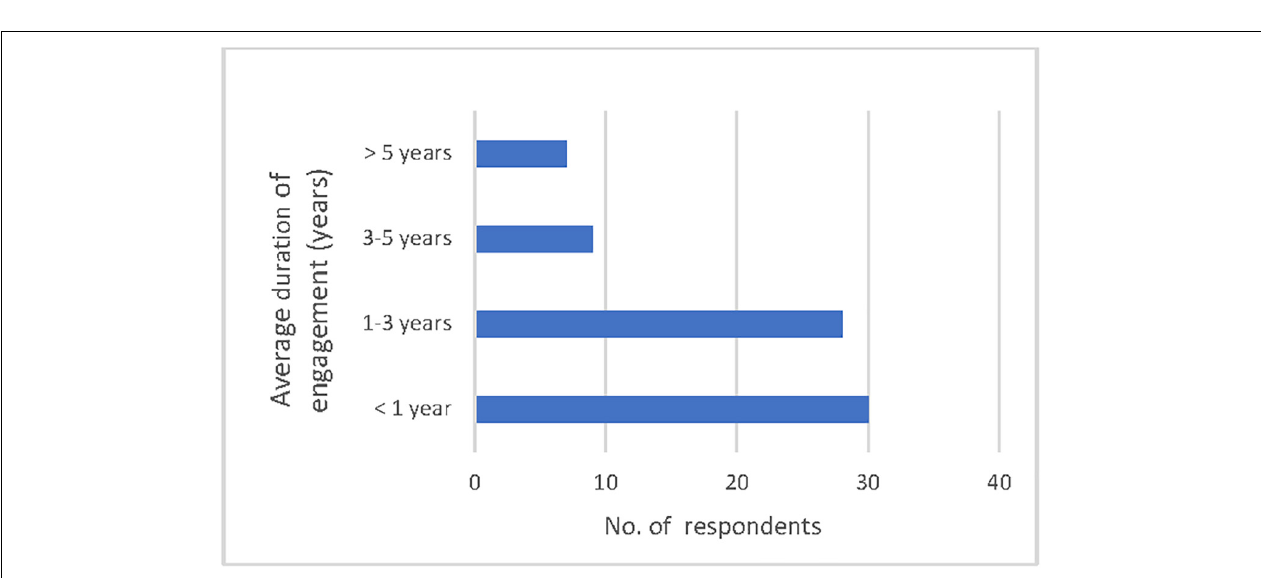
FIGURE 1 | Marine research projects over a scientist’s career to date (i.e., up to 26 June 2017) that included Indigenous engagement measured by number of survey respondents.